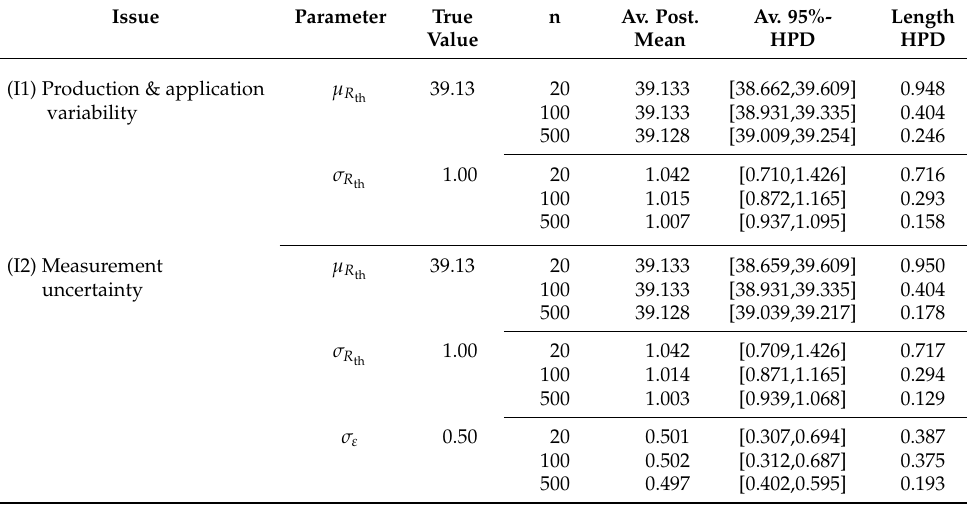
Figure 7. Visualization of Table 1: Distribution of posterior means for µ R 100 datasets (E1) for different sample sizes ( n 1 = 20, n 2 = 100 and n 3 = 500), true values (red circle) and (uniform) prior distributions (yellow line). Table 1. Simulation results for Issue 1 (I1, Section 4.2) and Issue 2 (I2, Section 4.3). Averaged posterior means (Av. post. mean) for µ R , σ R and σ ε (only I2); averaged lower and upper bounds of 95%-HPD th th regions (Av. 95%-HPD) for µ R , σ R and σ ε (only I2); and respective length of averaged 95%-HPD th th regions (Length HPD) over 100 datasets based on different sample sizes ( n 1 = 20, n 2 = 100 and n 3 = 500).